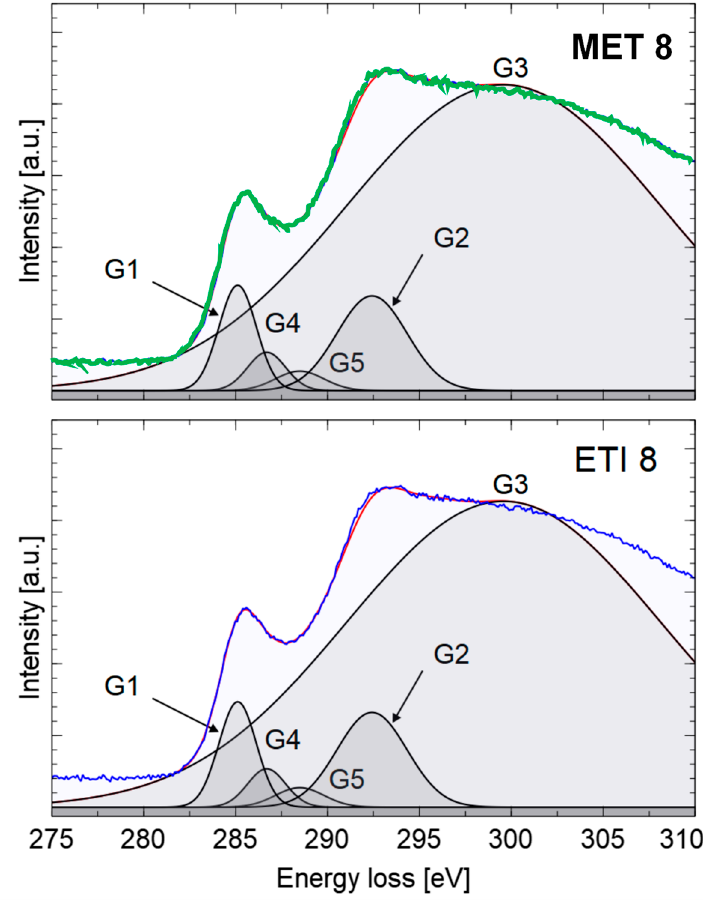
Figure 7. Deconvolution of the absorption curve CK of methane ( up ) and ethylene ( down ) soot.